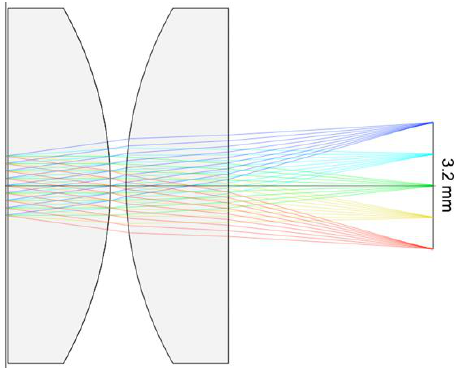
Figure 3. The AWSM custom-built SWIR camera.